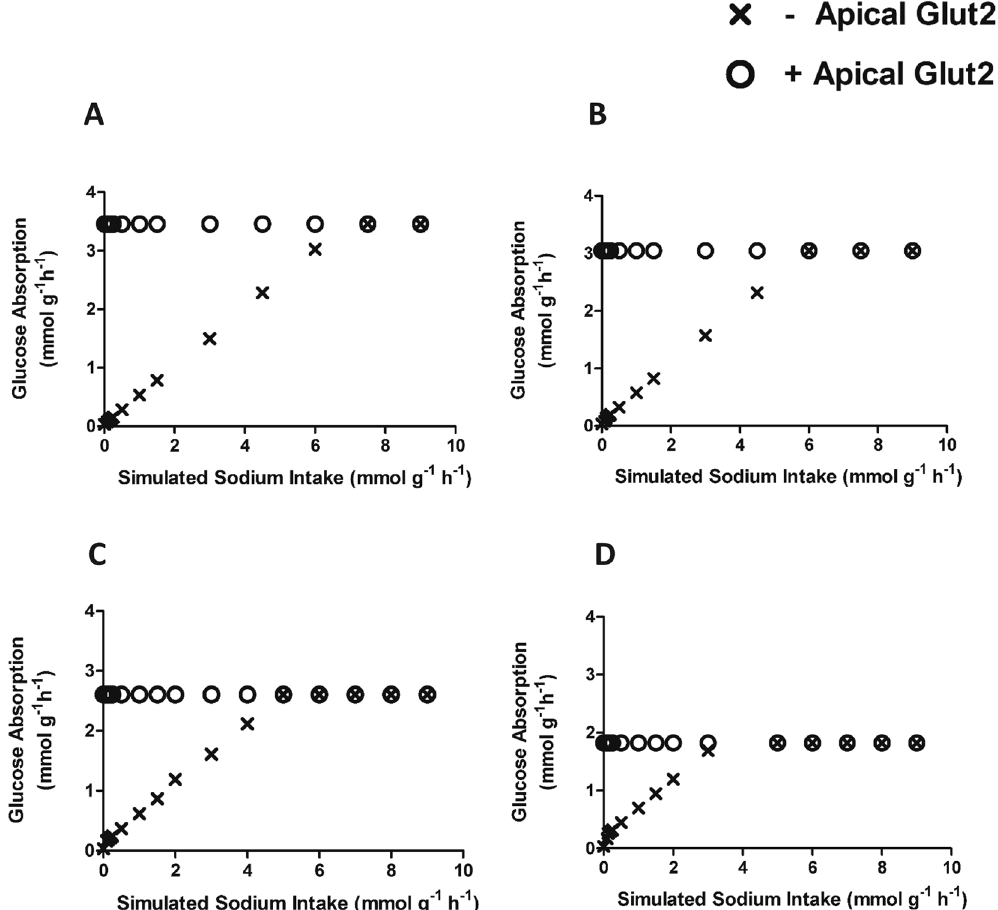
Figure 4. Glucose absorption versus simulated Na + intake in the presence ( + ) or absence ( − ) of apically located GLUT2. ( A ) Simulation results for the 10 en% diet; ( B ) Simulation results for the 20 en% diet; ( C ) Simulation results for the 30 en% diet; ( D ) Simulation results for the 45 en%